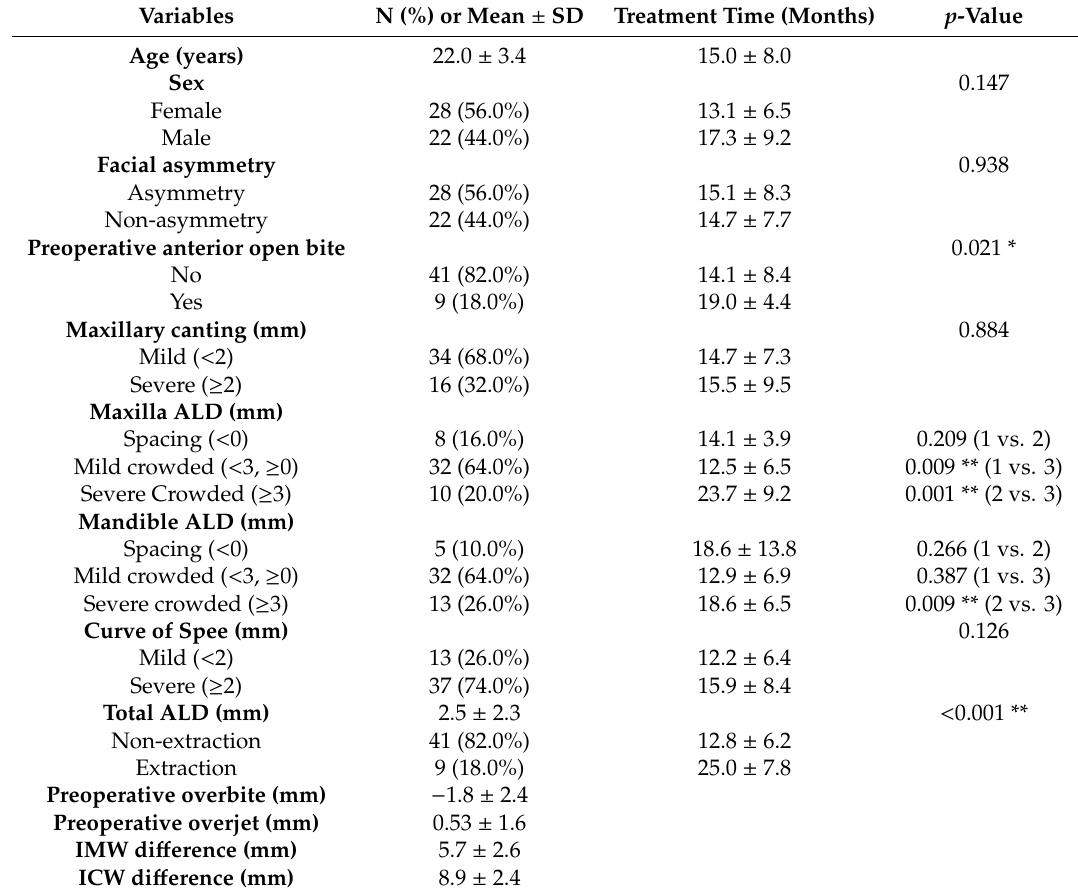
Table 1. E ff ects of demographic features on treatment time.